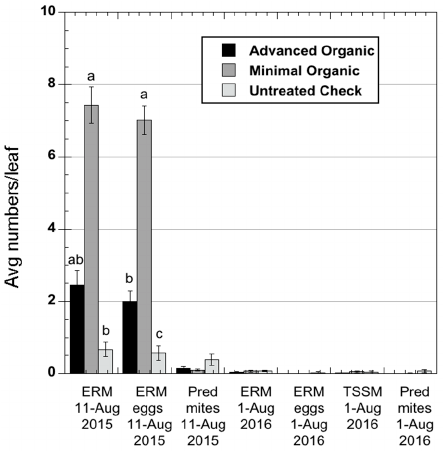
Figure 2. Average numbers per leaf of eggs and motile forms of European red mite, Panonychus ulmi (Koch), the predacious mite, Typhlodromus pyri (Scheuten), and twospotted spider mite, Tetranychus urticae Koch, in once-yearly foliar samples taken during 2015 and 2016.